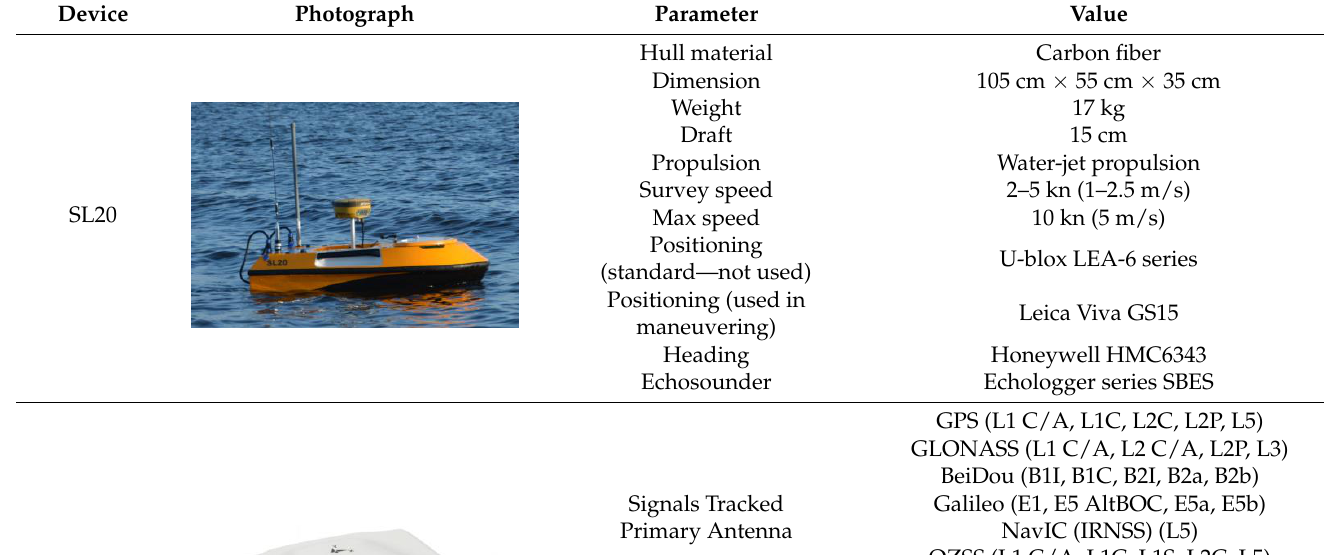
Table 1. Basic parameters of USV and sensors.